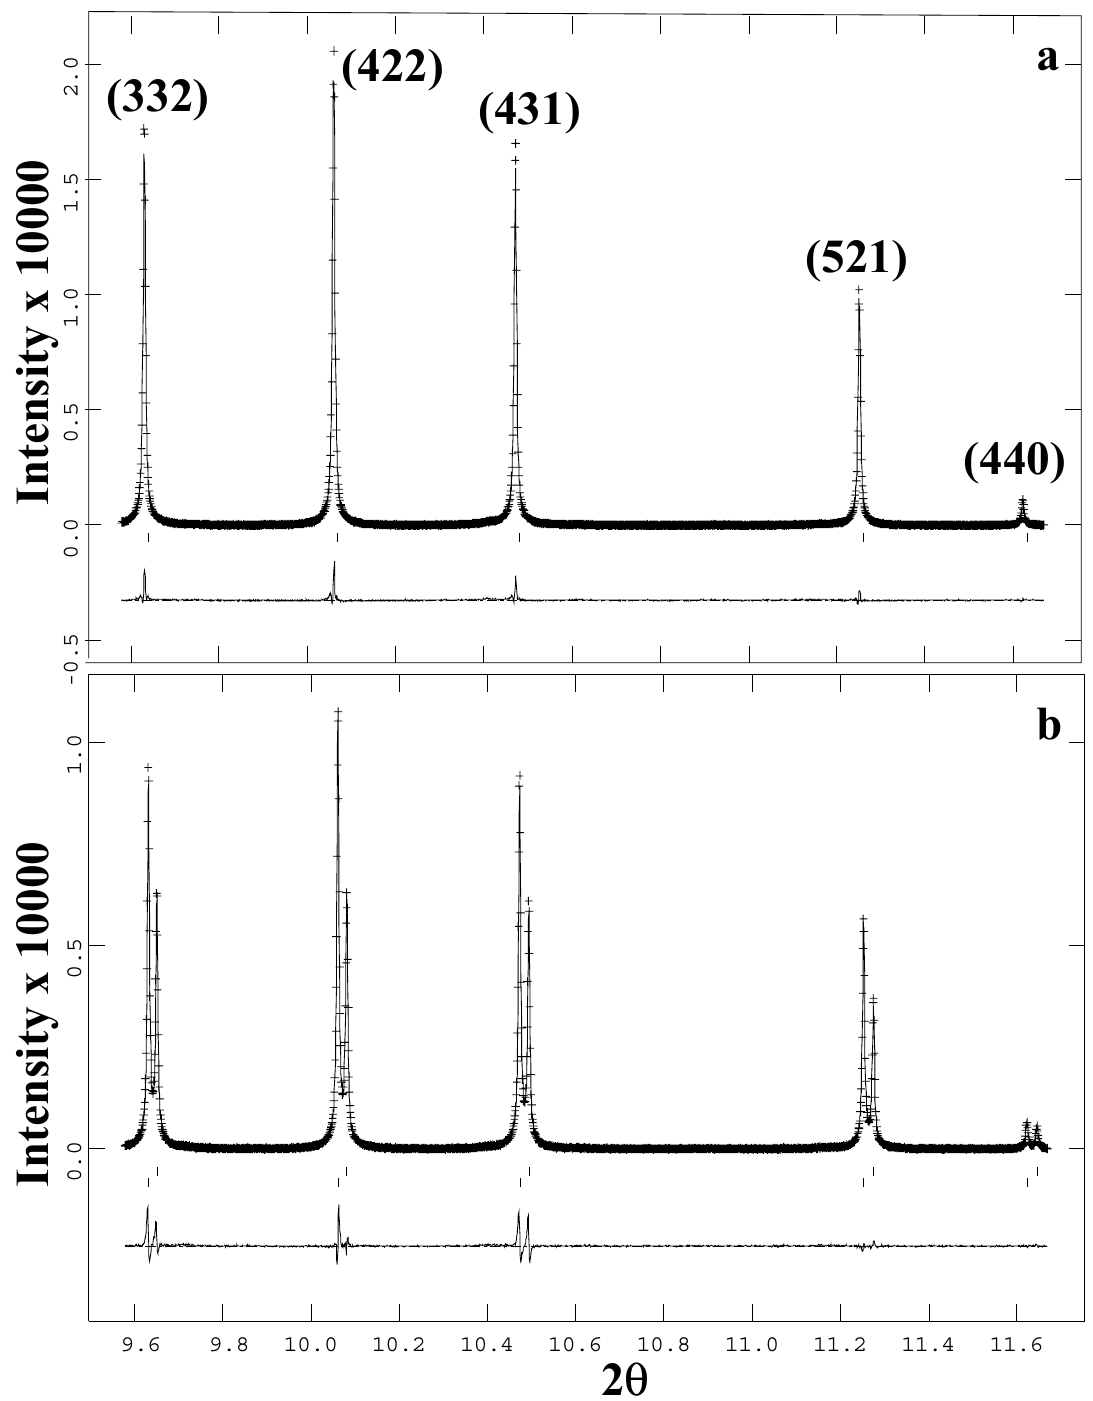
Figure 4. Expanded part of the HRPXRD traces showing no splitting of sharp reflections for sample 1 in ( a ), but splitting of sharp reflections into two for sample 2 in ( b ). The reflections in ( a ) are from a single phase, whereas those in ( b ) are from two cubic phases.